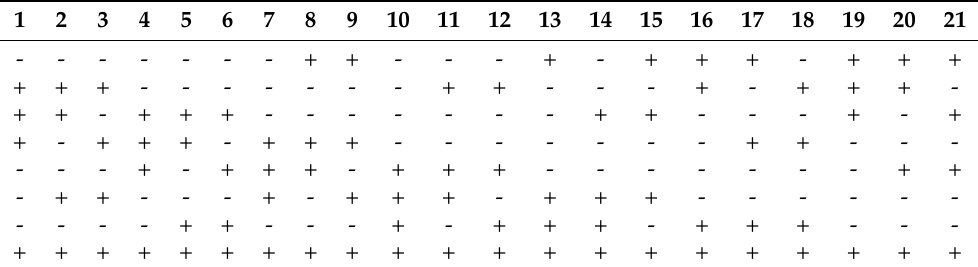
Table 7. A 3-circulant SSD.